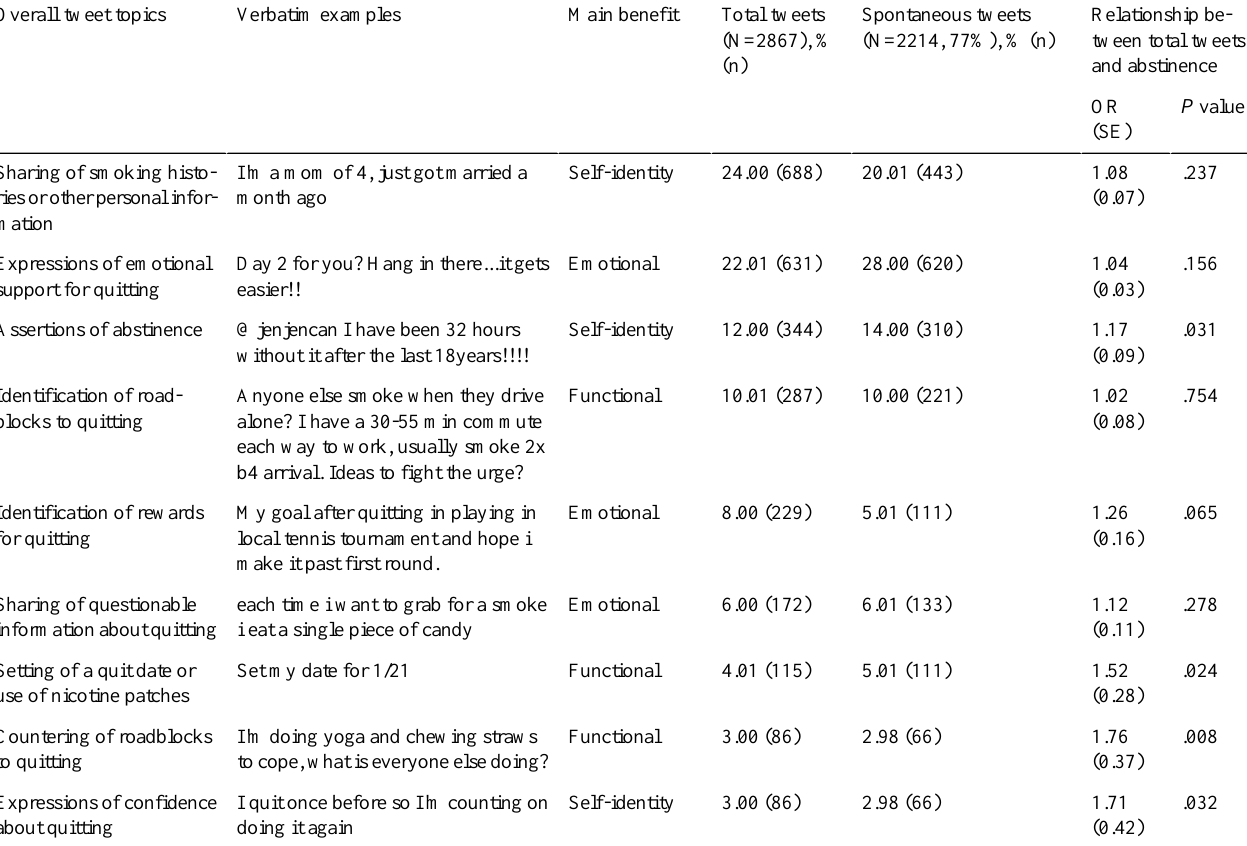
Table 2. Total tweets and spontaneous tweets by topic and abstinence a .